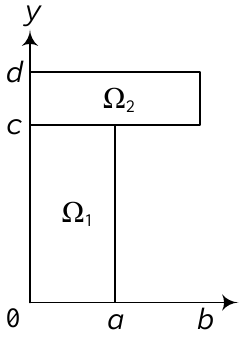
Figure 2 . A profile of the unit cell of the plate − gap